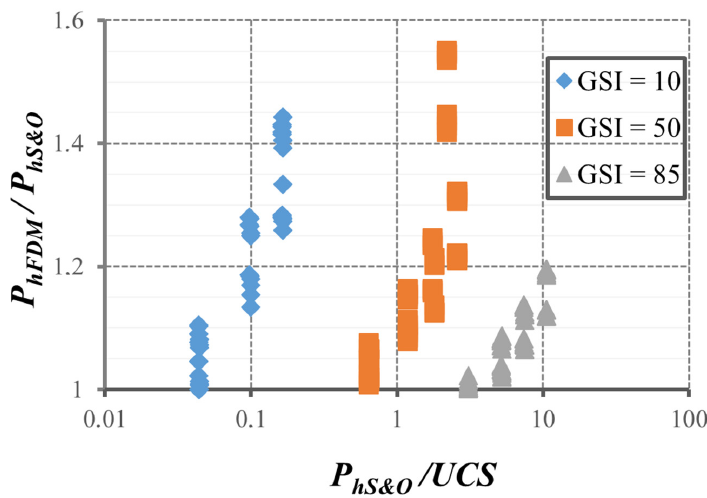
Figure 6. Relation between P hFDM and P hS&O depending on P hS&O /UCS in function of the GSI .